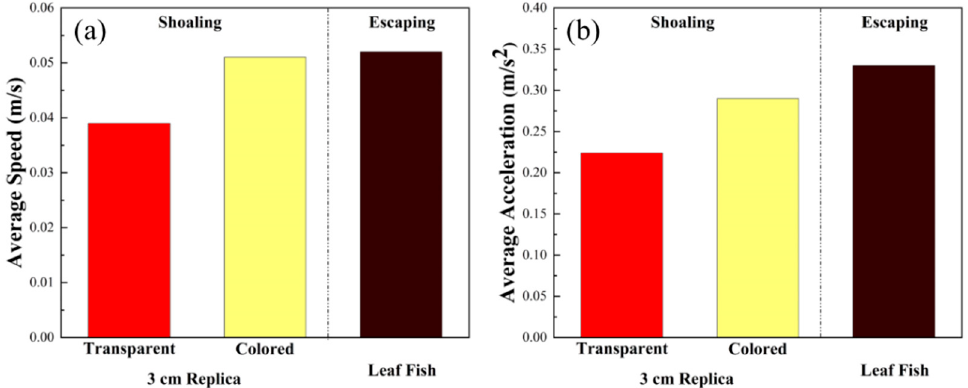
Figure 10. Comparison of ( a ) average speed and ( b ) average acceleration of real fish with transparent and colored replicas sized 3 cm and leaf fish replica (predator).